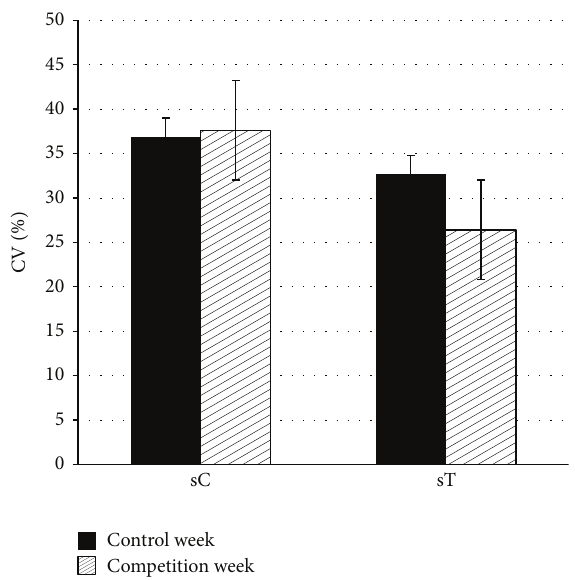
Figure 1: Percent coefficient of variability (%CV) of salivary cortisol (sC) and salivary testosterone (sT) during the control and competition week. Values are mean ± SE.